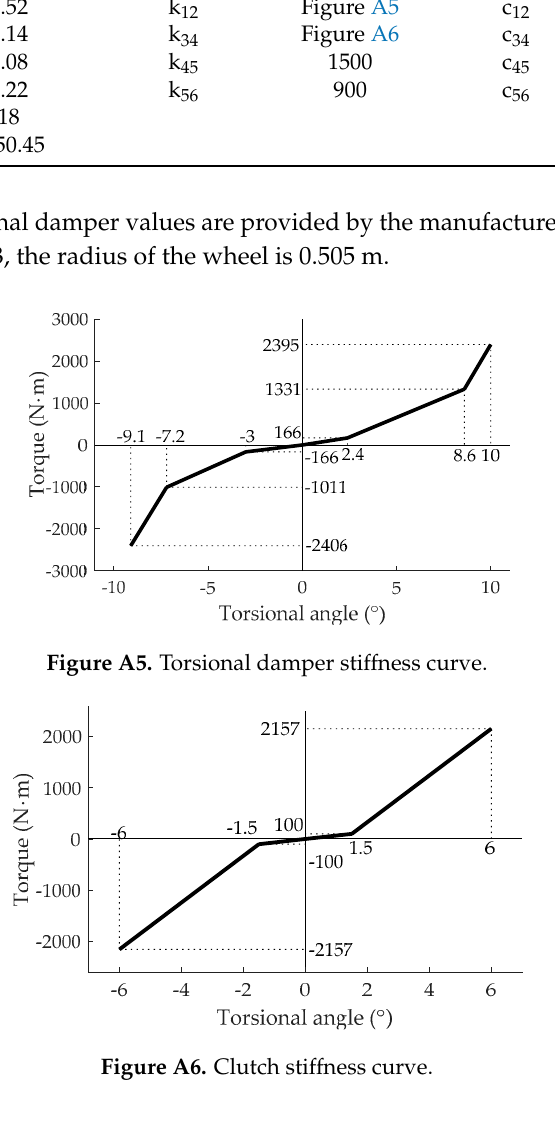
Table B1. Main components and parameters of the simulation system.